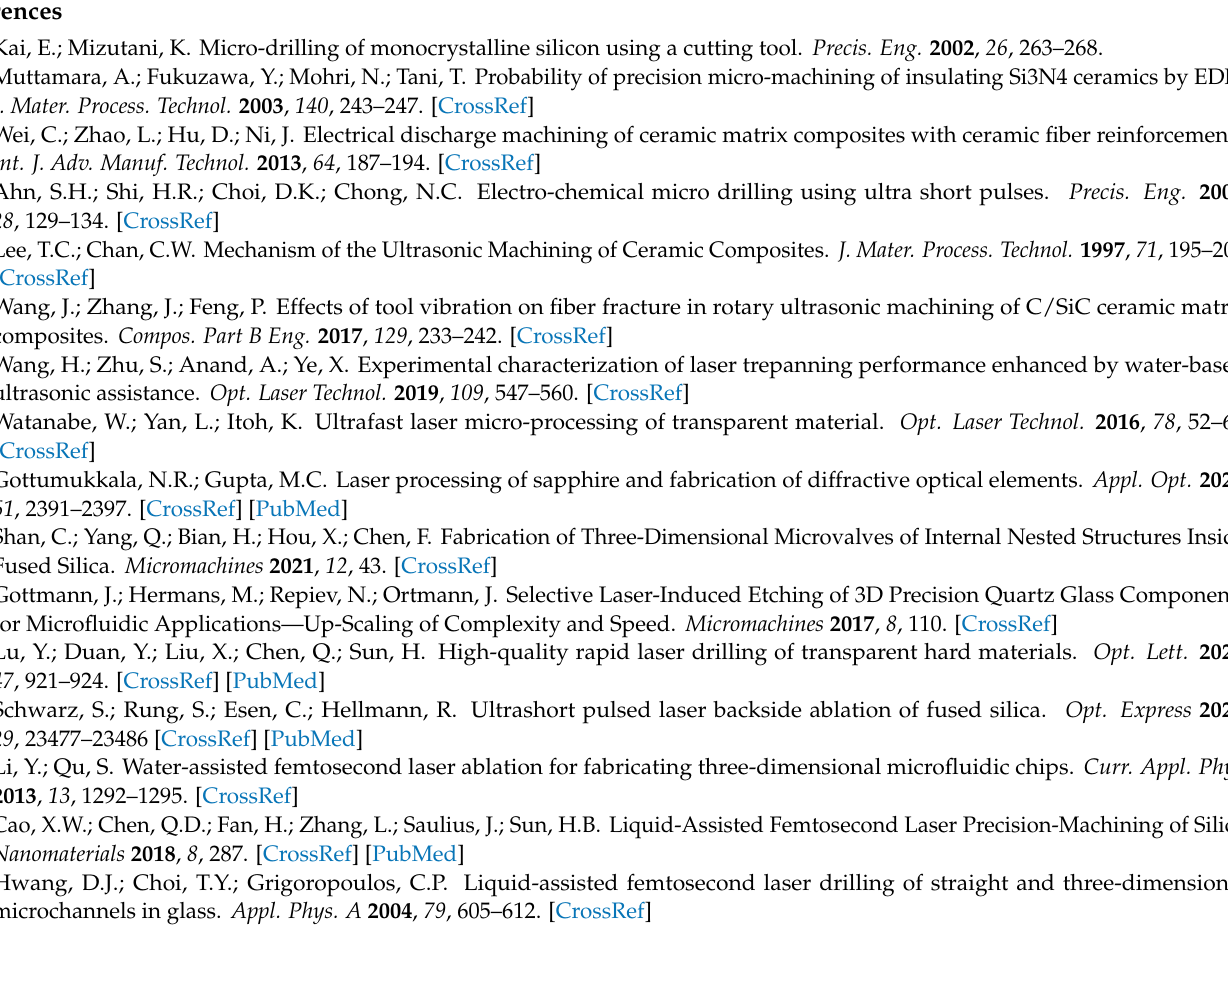
The effect of scan path on depth response is not obvious, but its interaction with the scan times has a more obvious effect on roughness. The regression prediction model of roughness versus depth was experimentally derived and validated in a 3-point factorial scheme, with all depth values of the tests falling within the PI and all roughness values falling within a tighter CI than the prediction interval, demonstrating the good predictive power of the prediction model. As high efficiency and low roughness are the first requirements of production, we used the optimized experimental parameters with a repetition frequency of 300 kHz, pulse energy 0.4 µJ, scan speed 50 mm/s, scan distance 0.5 µm, number of scan times 10, and defocus amount − 0.003 mm to process large depth microblind